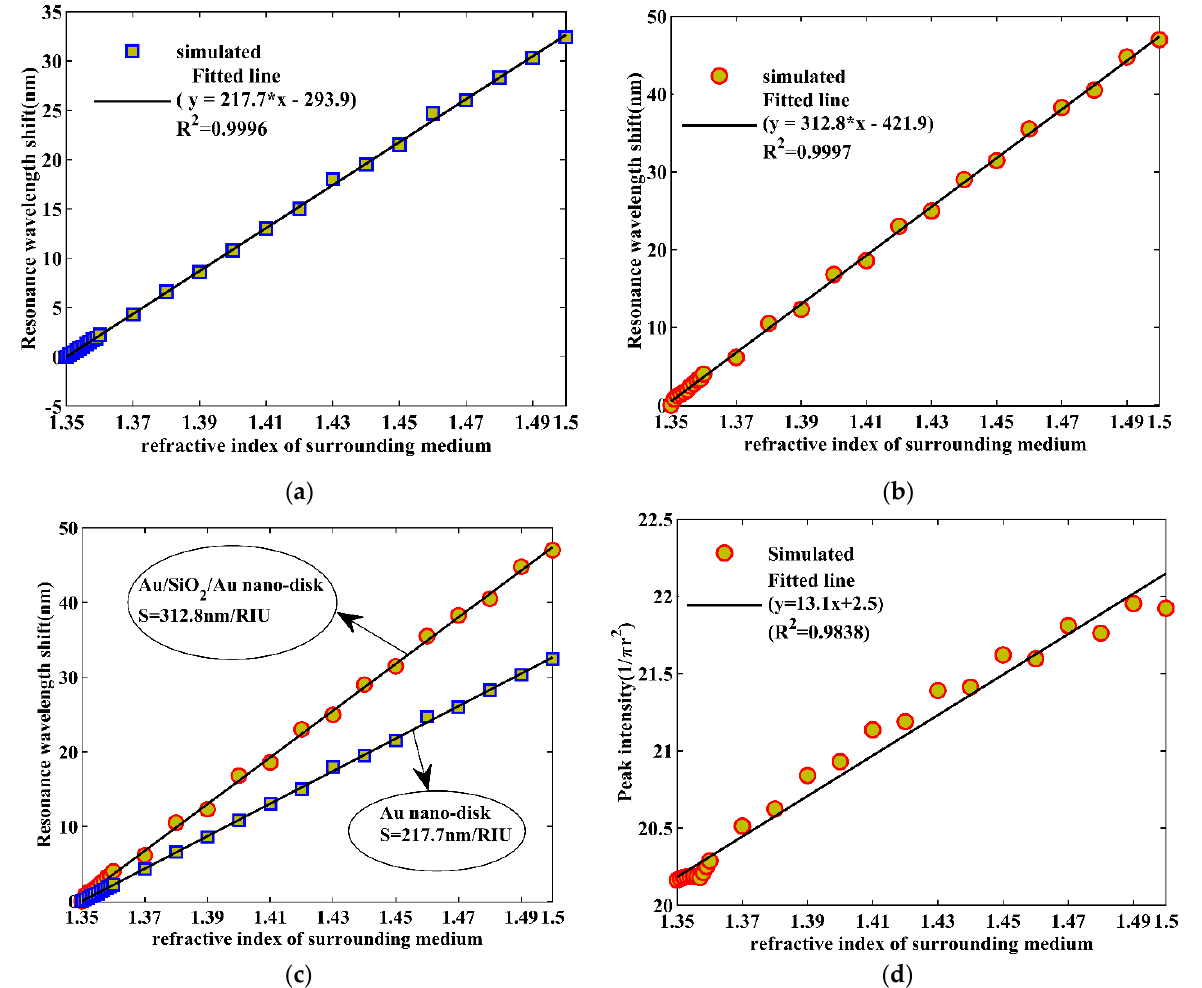
Figure 7. ( a ) Resonance wavelength shifts as a function of the refractive index of the surrounding medium for Au nano-disc. ( b ) Resonance wavelength shifts as a function of the refractive index of the surrounding medium for Au/SiO 2 /Au nano-disc. ( c ) Comparison of the sensitivity for Au/SiO 2 /Au nano-disc- and Au nano-disc-based biosensors. ( d ) Peak intensity as a function of the refractive index of the surrounding medium and ( c ).